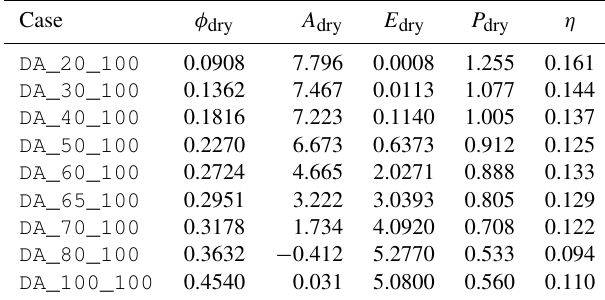
P dry . A dry + E dry